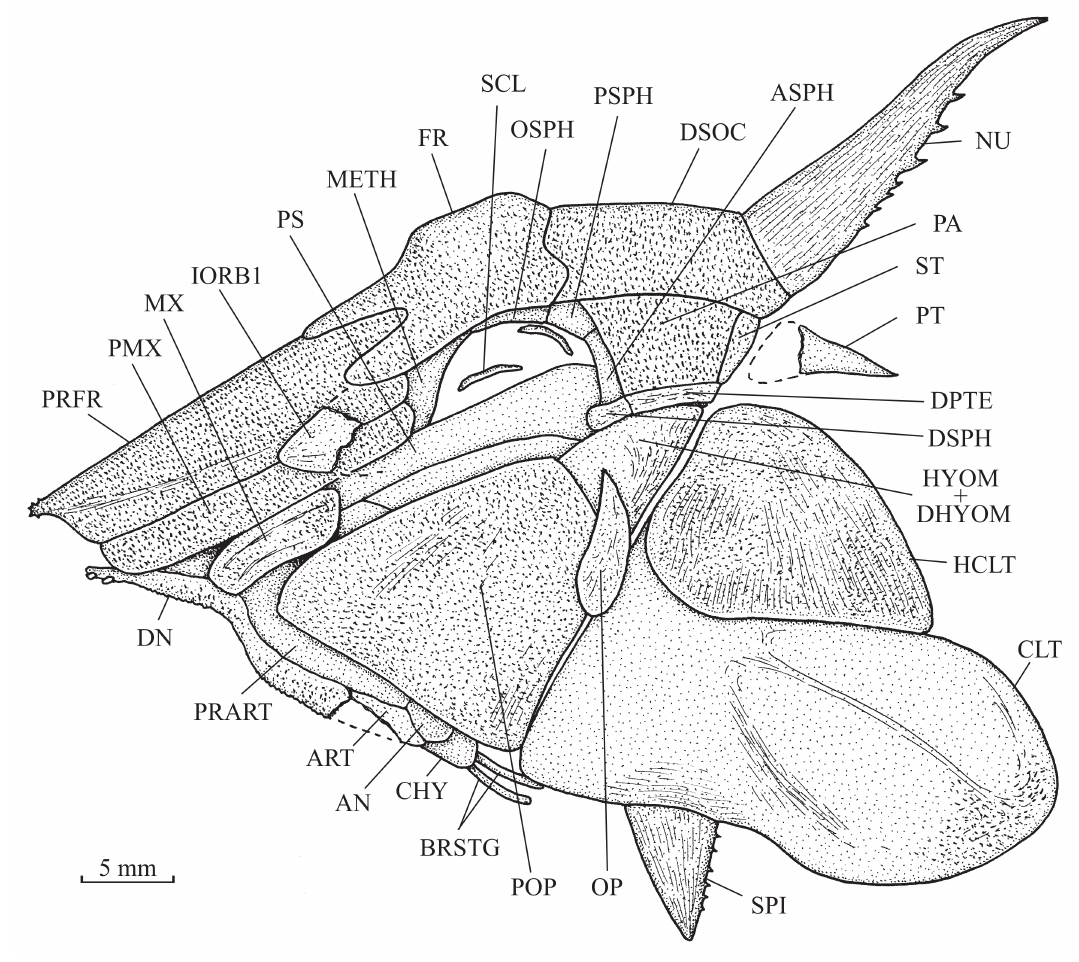
Fig. 14. Joinvillichthys kriweti gen. et sp. nov. Reconstruction of the skull and the pectoral girdle based on holotype, CLC